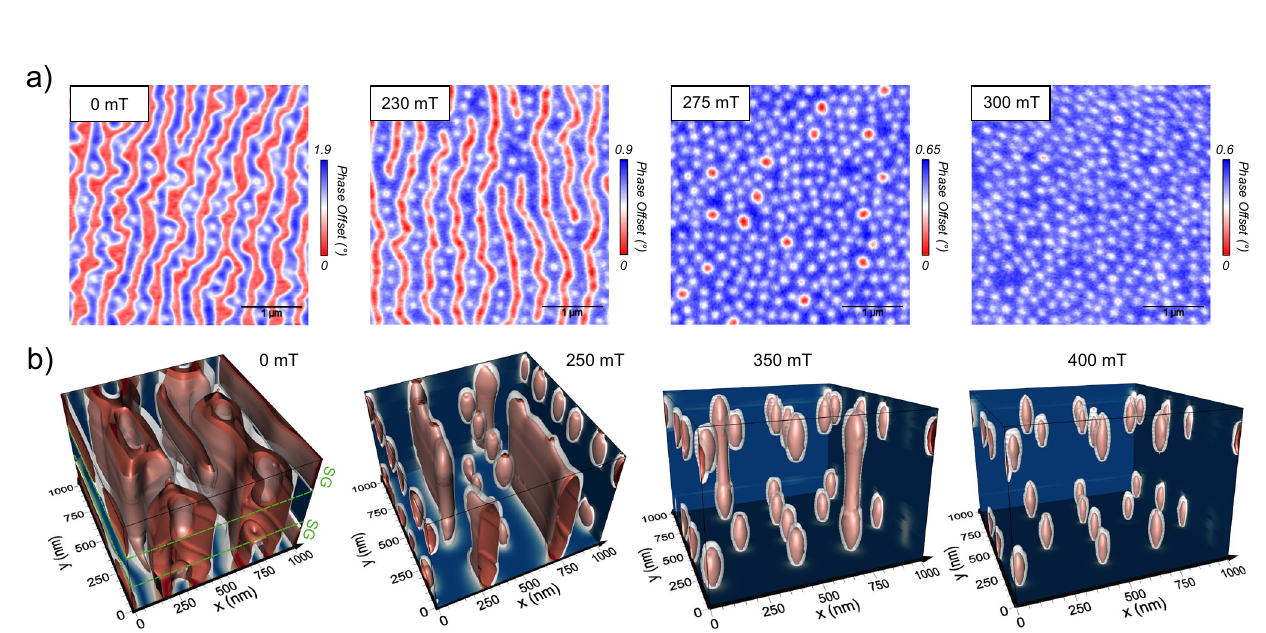
m z =0 and in dark blue, m z =1), at various magnetic fi elds starting from a 60 ∘ initialization. The magnetic fi eld is applied perpendicularly to the